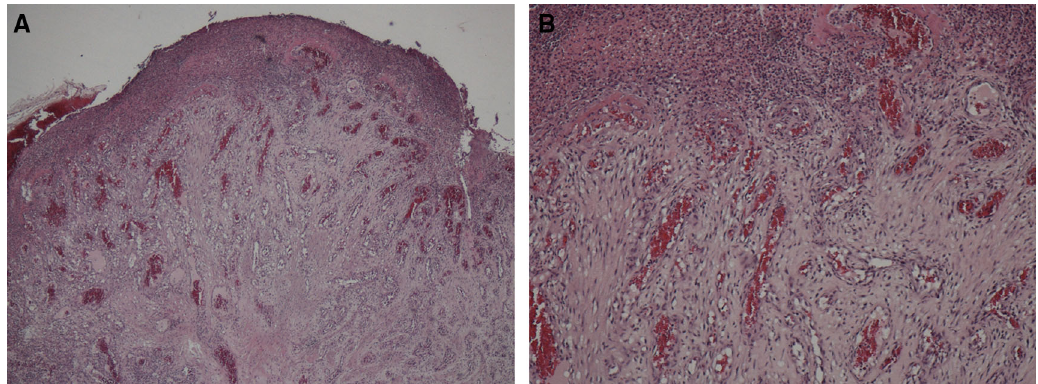
Figure 3. Pathohistological investigation. Histopathology section showing endothelial cell proliferation and distribution throughout the lesion, which are the characteristics of a pyogenic granuloma. A. At (cid:1) 10 magnification and B. At (cid:1) 40